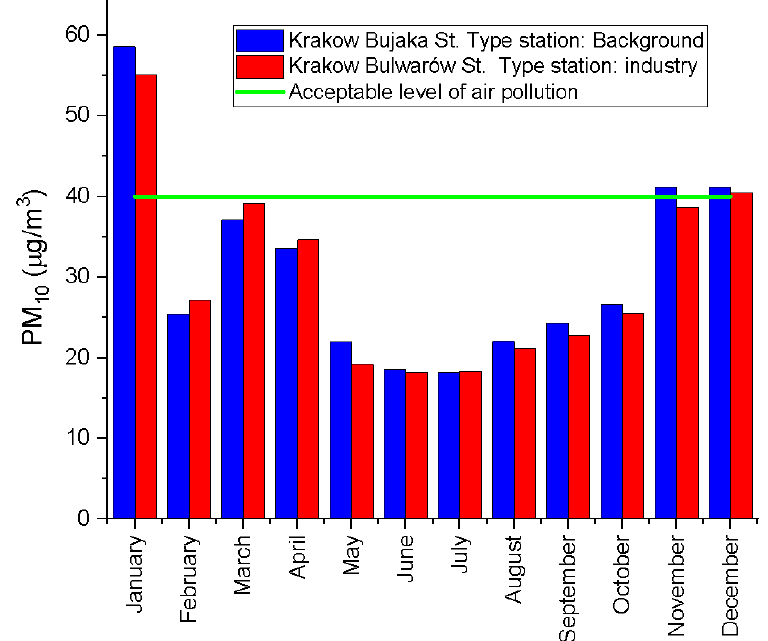
Figure 5. Average PM10 concentration in individual months of 2020.